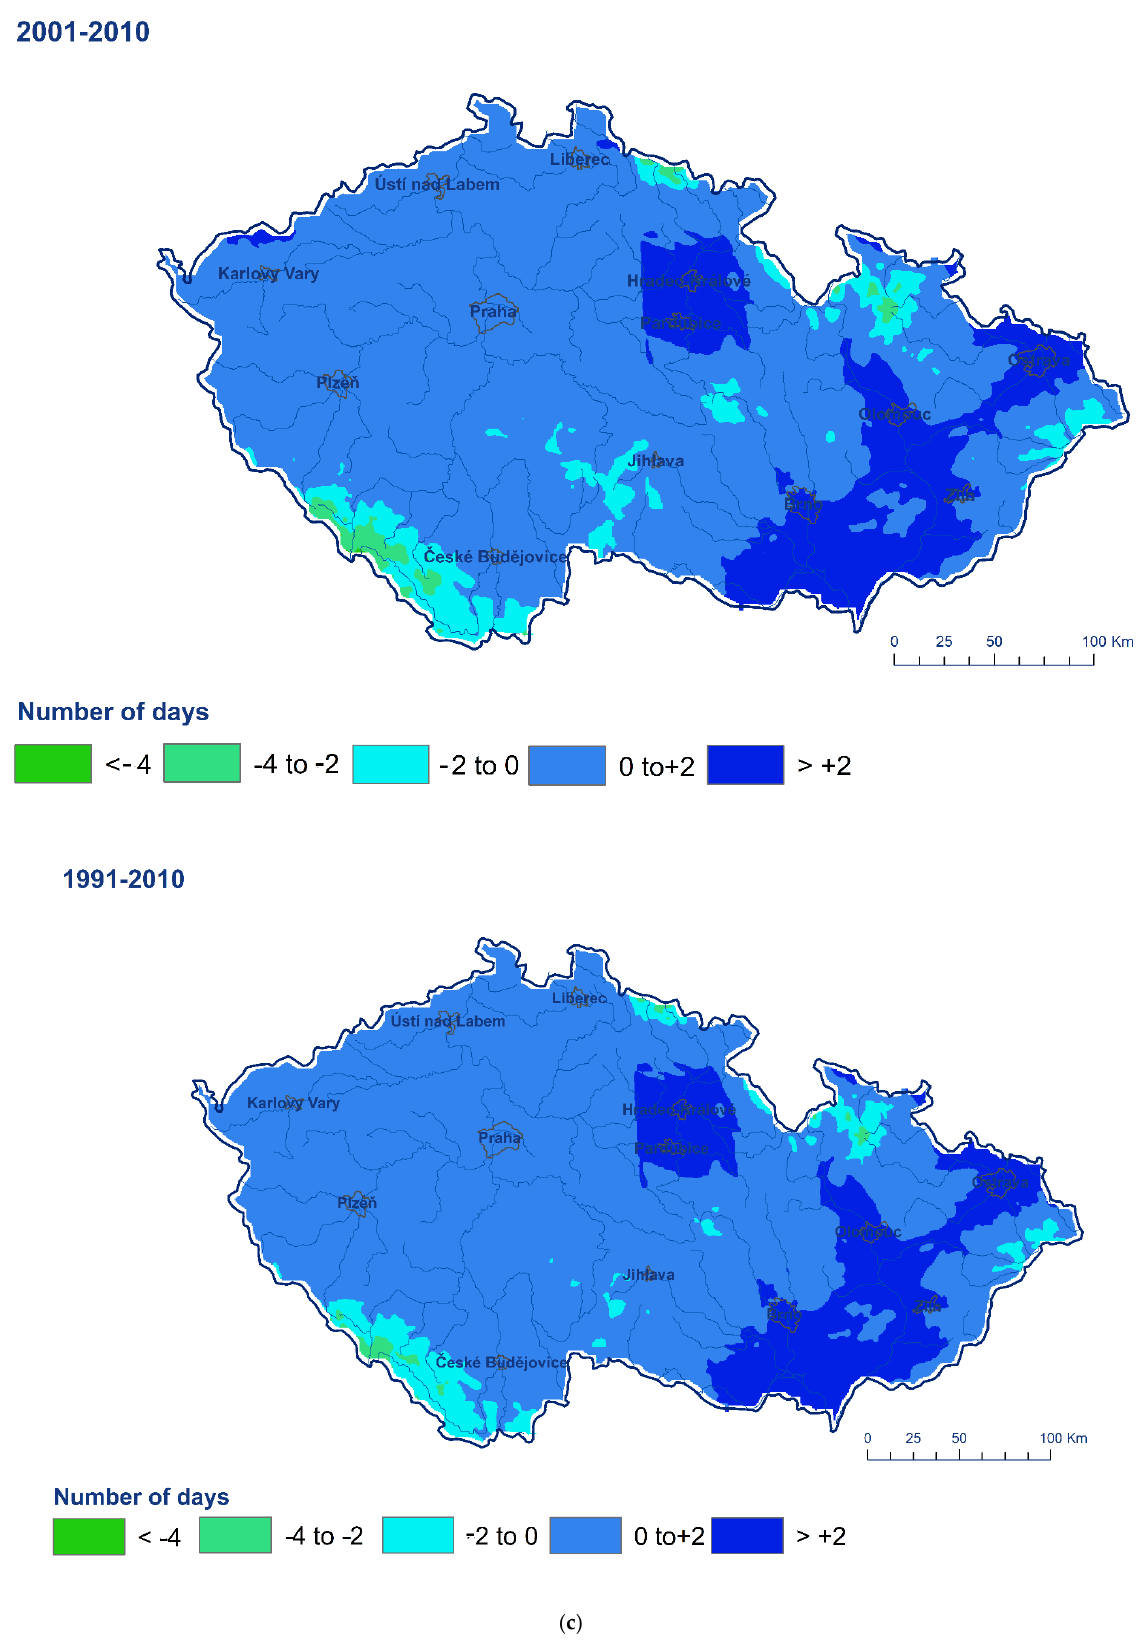
Figure 4. ( a ). Beginning of flowering of the Brassica napus in the Czech Republic within the 1991–2000, 2001–2010 and 1991–2010 periods. Results are based on the real observed data. ( b ). Beginning of flowering of the Brassica napus in